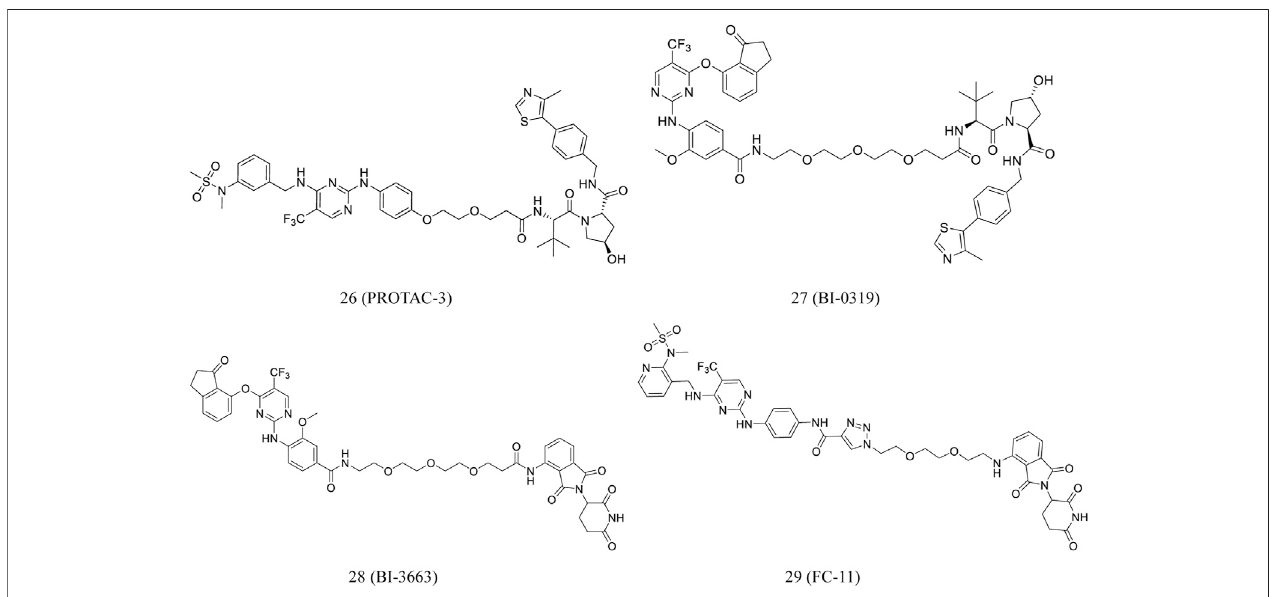
FIGURE 6 | Chemical structures of PROTACs targeting